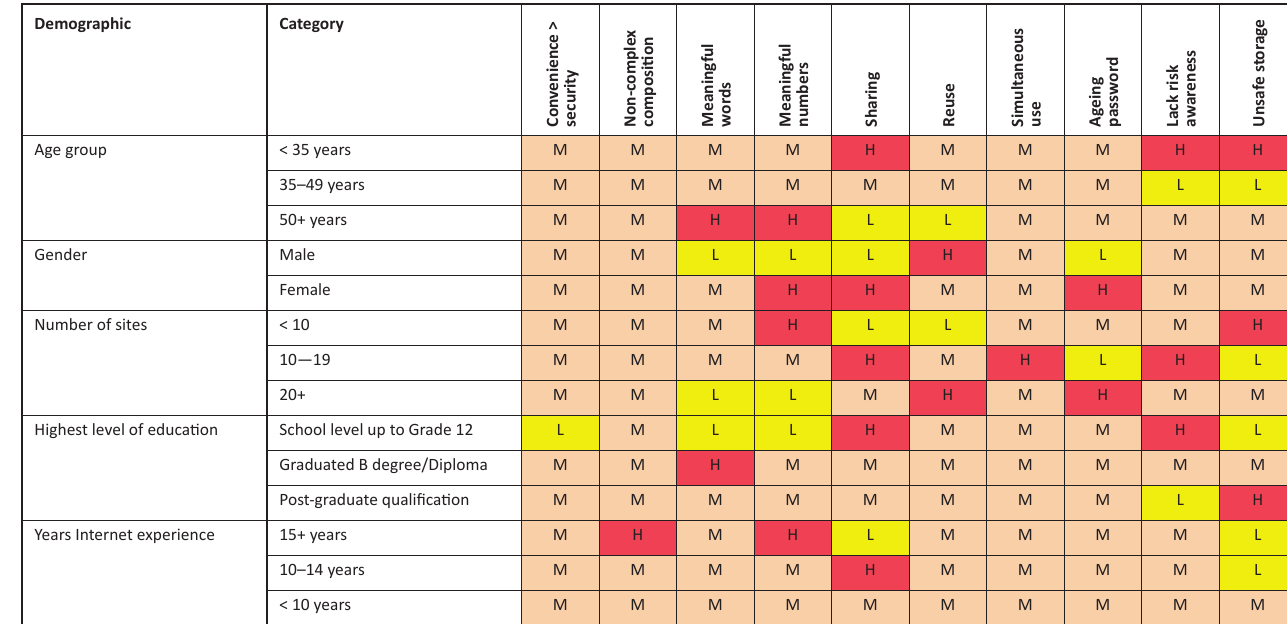
FIGURE 8: Focus areas for security education, training and awareness